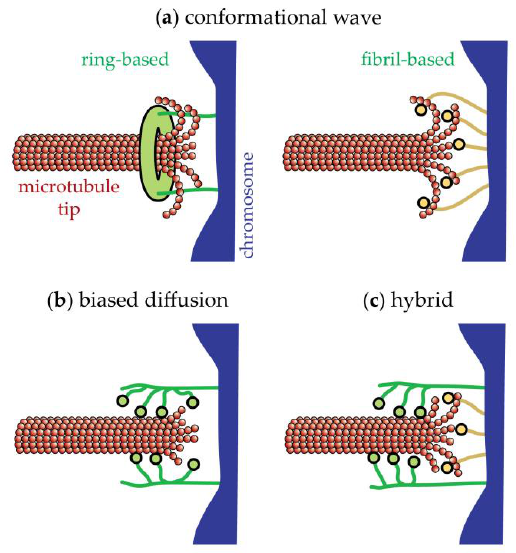
Figure 8. Models for tip-coupling without conventional motor activity. ( a ) Two versions of the conformational wave mechanism are shown, one (ring-based) in which elements of the kinetochore assemble into a microtubule encircling ring that is hooked by curling protofilaments, and another (fibril-based) where fibrillar kinetochore elements bind independently to the curling protofilaments. In either case, the curling action of the protofilaments exerts pulling force (directed leftward in the diagrams) on the chromosome. ( b ) In the biased diffusion mechanism, an array of kinetochore fibrils rapidly binds and unbinds the microtubule lattice at or near the tip. Thermal fluctuations of the chromosome that allow more fibrils to bind (leftward movements of the chromosome in the diagram) are favored by the energy of binding those elements. This biased thermal movement produces a thermodynamic pulling force. ( c ) A hybrid model is also shown, where force is produced by a combination of protofilament curling and biased thermal fluctuations. These diagrams are adapted from [159], and are displayed with permission from Elsevier Publishing (http://www.sciencedirect.com/science/journal/09628924). Dam1c rings are not found outside fungi, but their absence does not necessarily rule out the conformational wave mechanism. Other molecules and structures could harness curling protofilaments. In humans and other eukaryotes, for example, the Ska complex might act as an attachment-stabilizer in a manner similar to Dam1c [121,122,165]. Ska complex does not appear to form oligomeric microtubule-encircling rings, but like Dam1c it can track with disassembling tips [166]. The Ska complex also dimerizes and might form lateral bridges between neighboring Ndc80 complexes [122]. Curling protofilaments might hook these lateral bridges. High-resolution electron tomograms show protofilaments curling outward from the tips of kinetochore-attached (and non- kinetochore) microtubules in mammalian (PtK1) spindles [138,167]. Sometimes fibrils can be discerned emanating from the kinetochores and connecting to the protofilament curls [138], suggesting the presence of a fibrillar protein with preferential affinity for curved protofilaments. Consistent with this possibility, the kinetochore protein Cenp-F contains an N-terminal microtubule- binding region that binds preferentially to ring- and curl-shaped tubulin oligomers (formed in the presence of dolastatin-10 and vinblastine, respectively) [168]. Beads decorated with N-terminal portions of Cenp-F can track with disassembling microtubule tips against forces of 3 pN [168], suggesting that its curl-binding activity could make a significant contribution to tip-coupling.